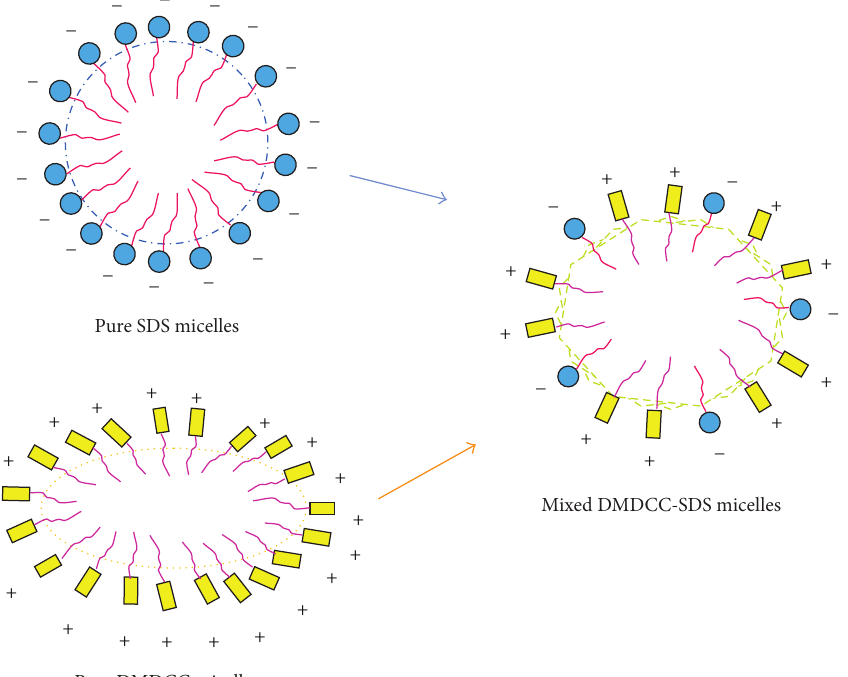
Figure 3: Schematic representation of the mixed DMDCC-SDS micelles compared to pure DMDCC micelles and pure SDS micelles.